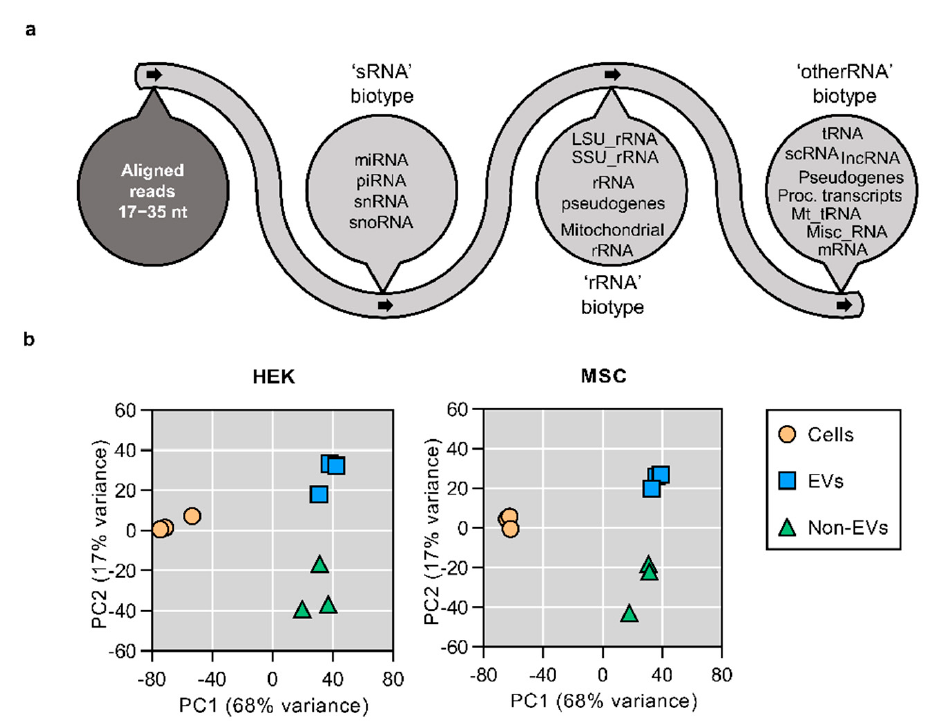
Figure 2. Sequencing workflow and Principal Component Analysis of all uniquely annotated reads. ( a ) RNA was extracted from EV and Non-EV fractions and subjected to sequencing. RNA sequences with a read length of 17 – 35 nt were aligned to the human genome and annotated in a stepwise manner first to the ‘sRNA’ biotype (miRNA, piRNA, snRNA, snoRNA), then to the ‘rRNA’ biotype (LSU_rRNA, SSU_rRNA, rRNA pseudogenes, mitochondrial rRNA) and finally to the ’otherRNA’ biotype (tRNA, scRNA, lncRNA, pseudogenes, processed transcripts, mt_tRNA, misc_RNA, mRNA). ( b ) Principal Component Analysis of all uniquely annotated reads of both HEK (left panel) and MSC (right panel) samples showed clear cluster separation of the cell, EV and Non-EV samples. Looking at the principal component 1 (PC1, explaining 68% of variance), the secretory fractions of both samples are more similar to each other than to parent cells.